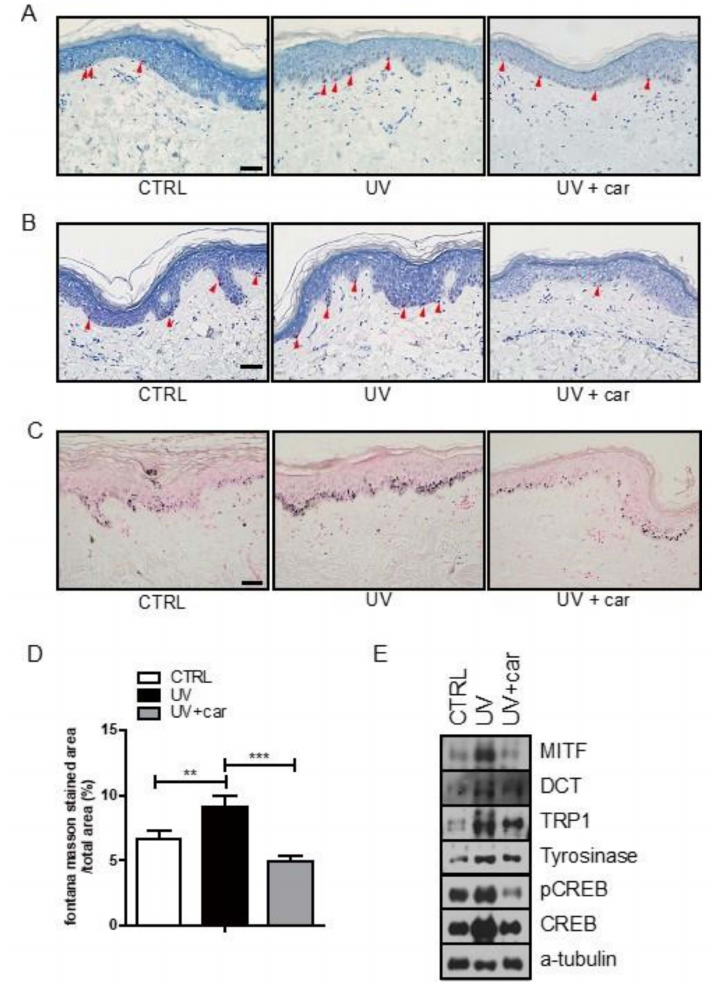
Figure 3. Carvedilol suppresses UVR-induced melanin accumulation in ex vivo human skin. ( A ) Microscopic images of Melan-A immunohistochemistry for melanocyte staining. Arrowheads indicate positive Melan-A staining (red color). Bar = 50 µ m. ( B ) Microscopic images of HMB45 immunohistochemical staining for melanocytes. Arrowheads indicate positive HMB45 staining (red color) Bar = 50 µ m. ( C ) Representative images of Fontana–Masson-stained para ffi n-embedded sections treated with vehicle (control), UVB + vehicle, or UVB + carvedilol. Bars = 50 µ m. ( D ) The ratio of the Fontana–Masson-stained area per total area for control, UVB, and UVB + carvedilol. ( E ) Cell lysates of control, UVB, and UVB + carvedilol were analyzed by Western blot using antibodies, MITF, DCT, TRP1, tyrosinase, and p-CREB, and total CREB and equal protein loading were confirmed by α -tubulin. Data are expressed as the means ± SD of three independent experiments. ** p < 0.01, *** p < 0.001 vs.